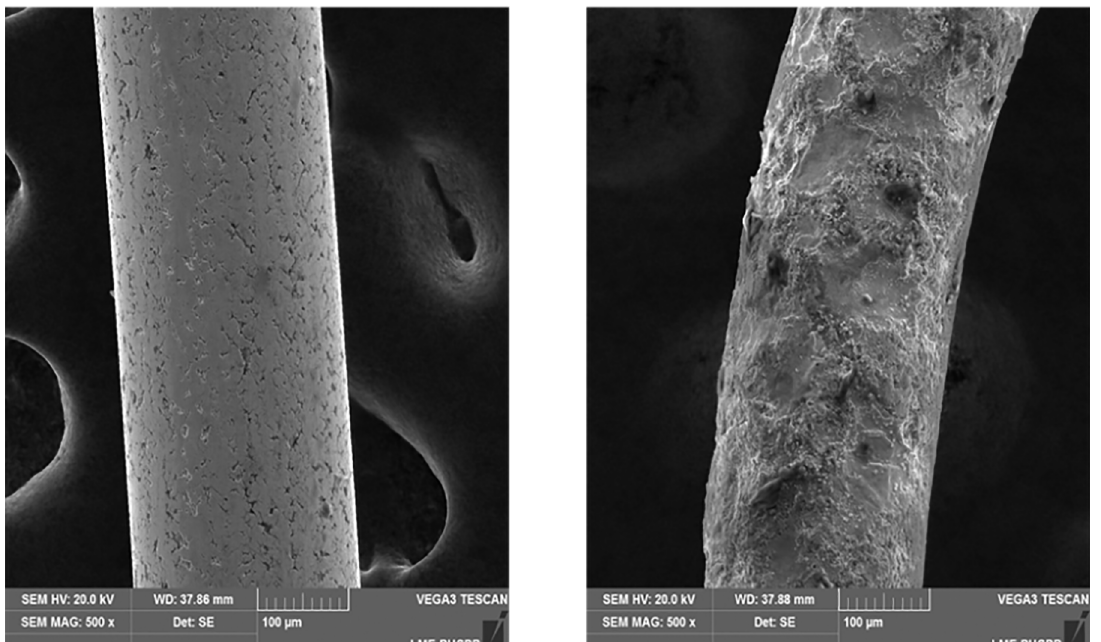
Figure 5. The influence of discharge duration t for brass and zinc-coated copper rate V f